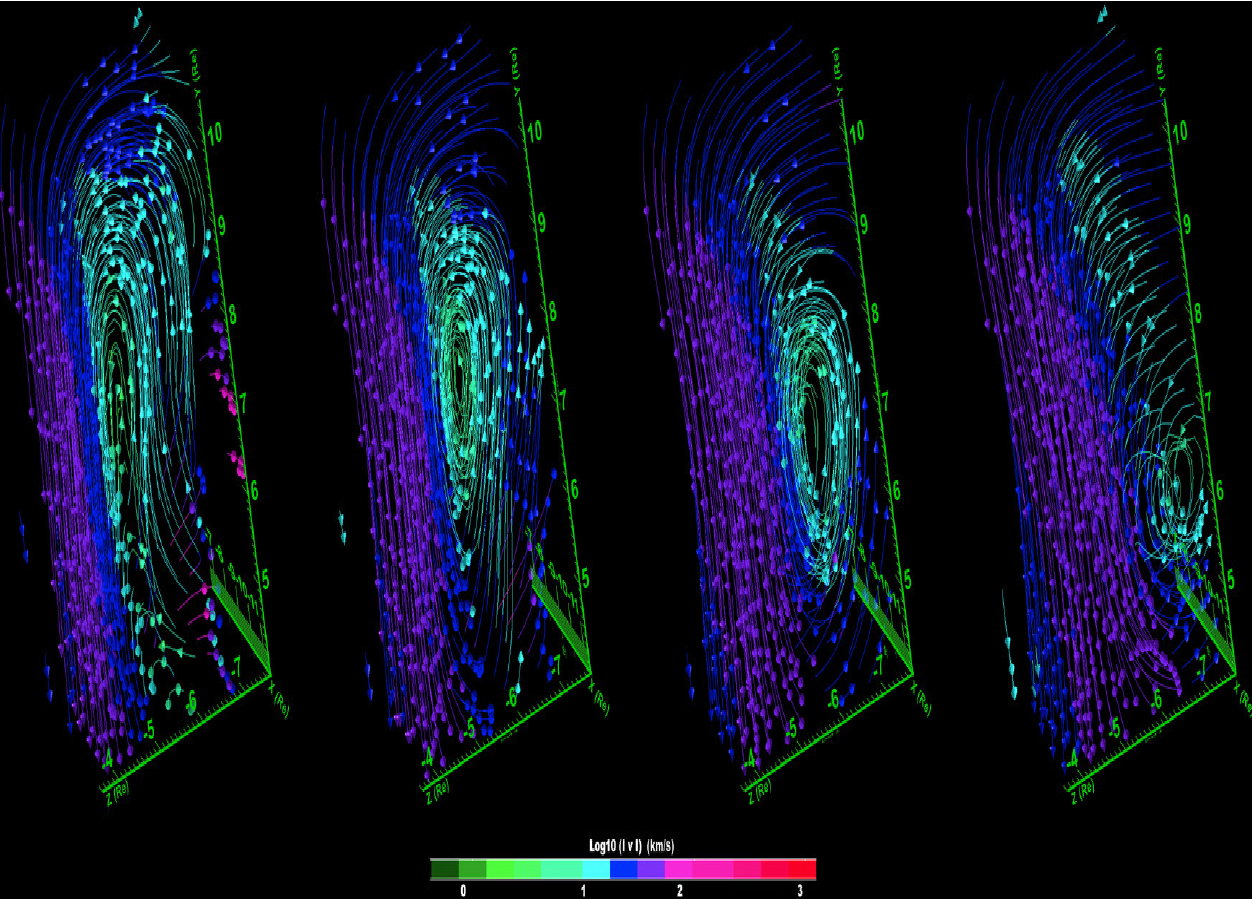
Fig. 19. This dusk flank vortex lasts for more than 30min. All four boxes are exactly ten minutes apart, but have the same spatial dimensions. The vortex core is not swept tailward, it remains fixed and it starts to dissipate around 02:12UT (last